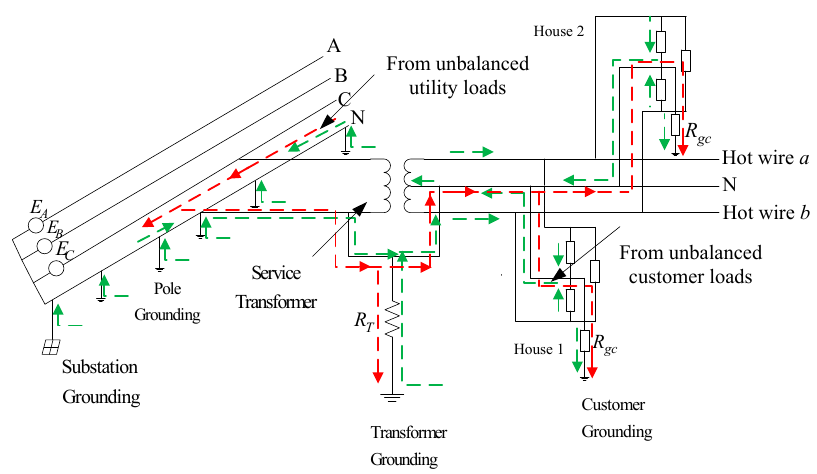
Figure 1. The single line diagram of the three-phase four-wire multi-grounded neutral system.